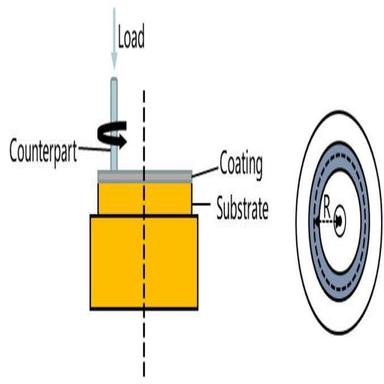
SEM images of feedstock powders: Yb2Si2O7 (a), hBN (b).